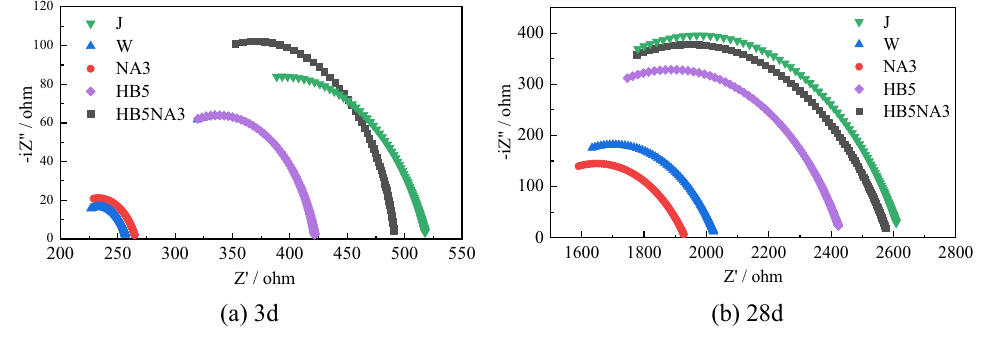
Fig. 18 Nyquist diagrams of the EIS test